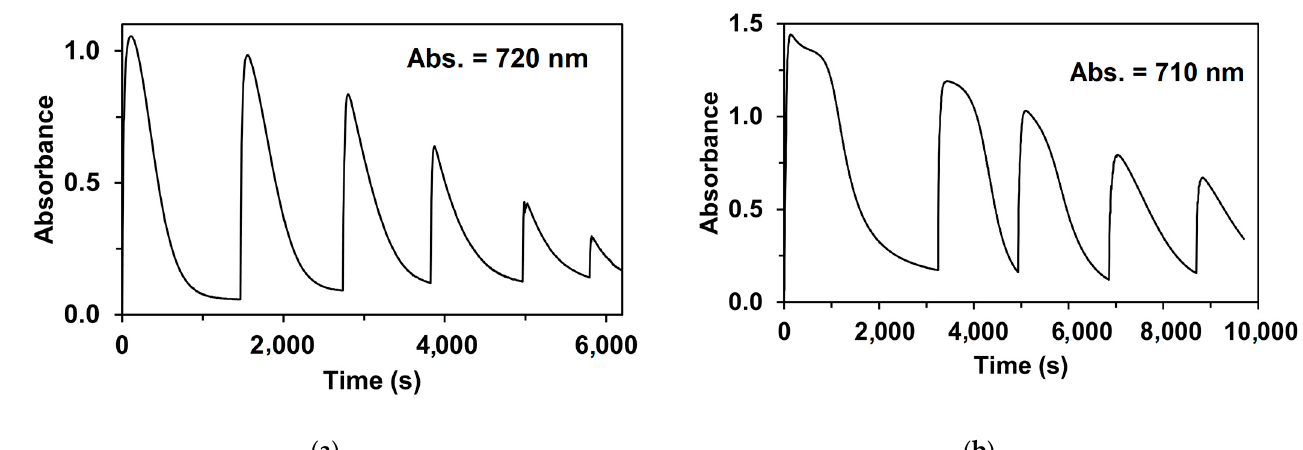
Figure 4. Time course of the formation and decay of µ -1,2-peroxo-diiron(III) ( 1 P and 4 P ) complexes generated in the reaction of 1 and 4 with 4 equivalent of H 2 O 2 for 5–6 cycles. ( a ) Generation and decay of 1 P for 6 cycles. ( b ) Generation and decay of 4 P for 5 cycles. [ 1 and 4 ] 0 = 1.0 × 10 − 3 M, [H 2 O 2 ]